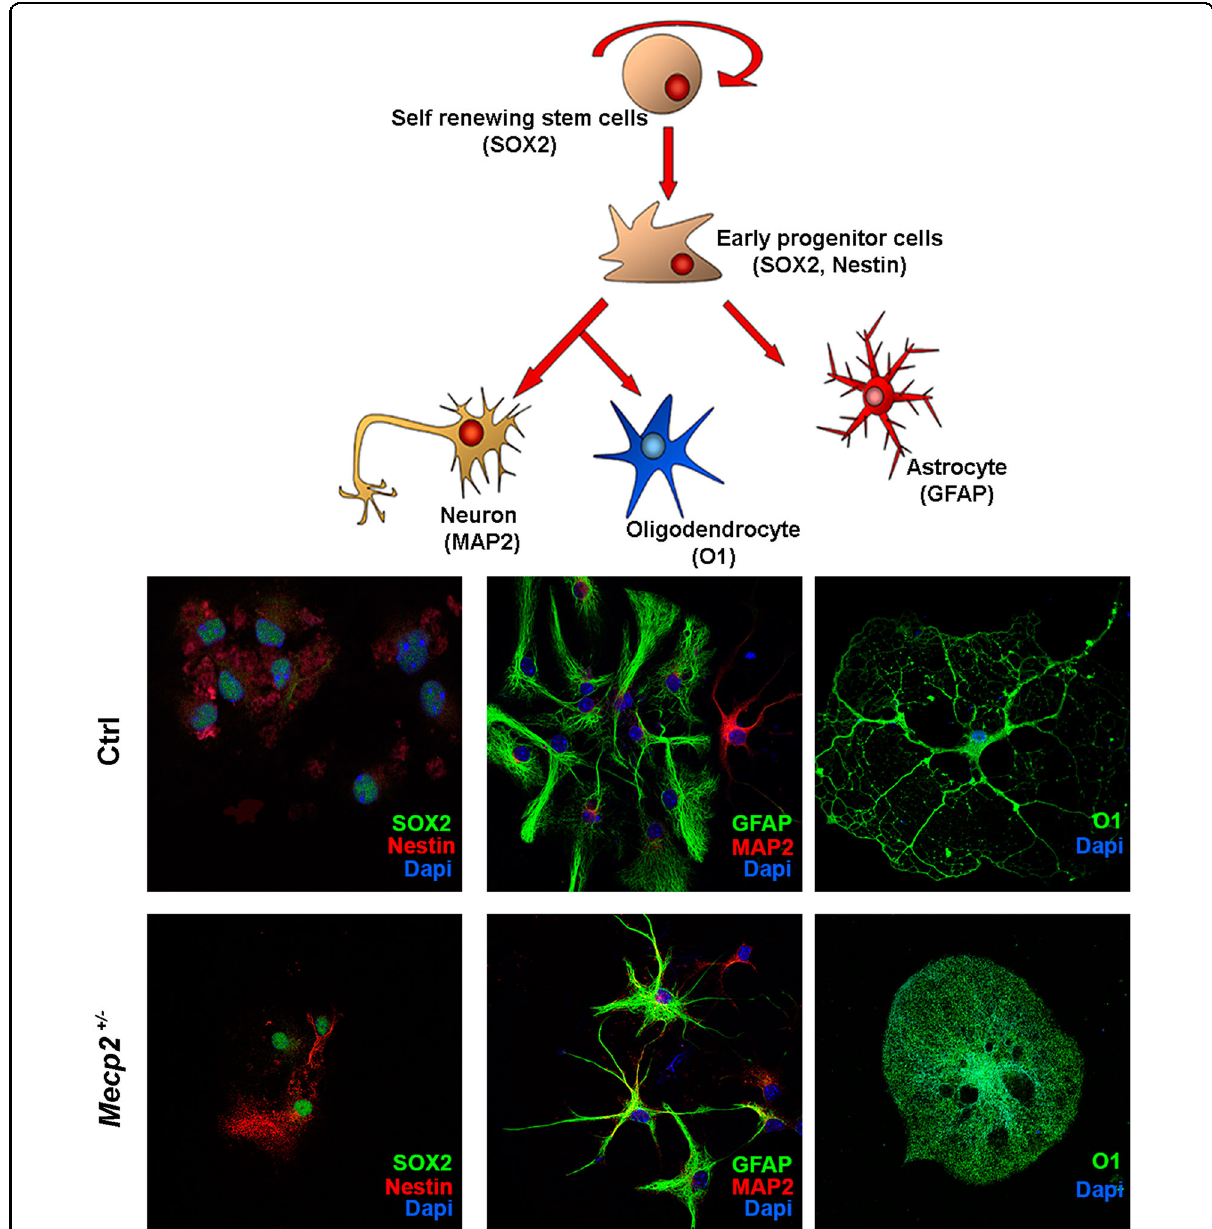
Fig. 4 NSC differentiation. Representative photomicrographs of Mecp2 + / − and control NSCs differentiated for 3 days onto poly- L -ornithine-coated plates in medium without growth factors. The cells were stained for SOX2, Nestin, MAP2, GFAP, and O1. The nuclei were counterstained with